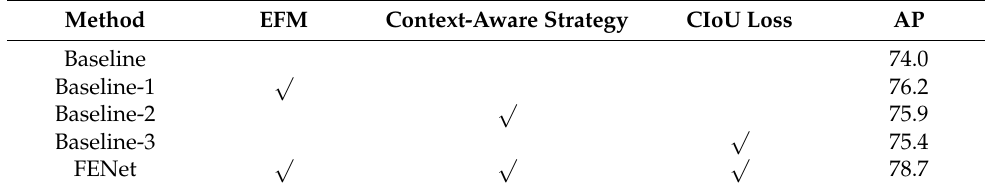
Table 2. The performance of different components of our proposed